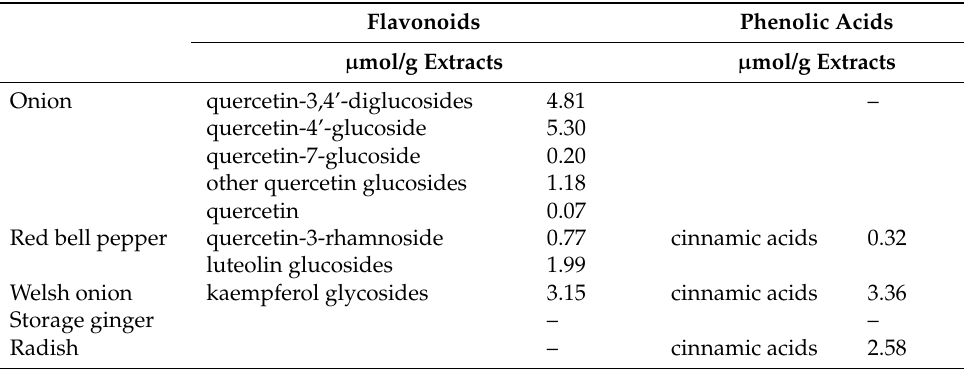
Table 1. Flavonoids and phenolic acids in vegetable